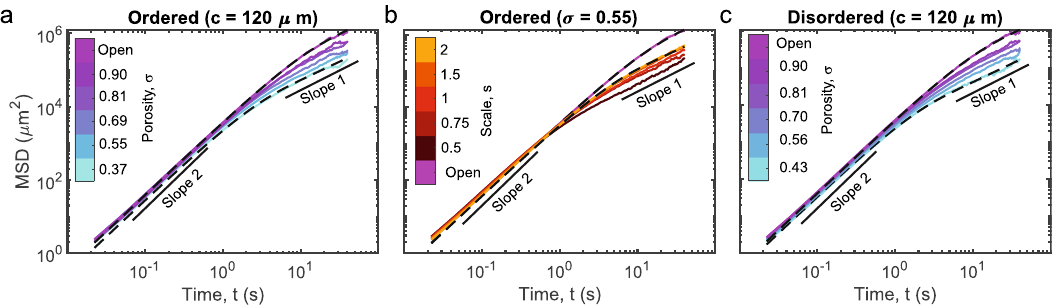
Fig. 3 Porous media universally hinders cell transport. Measured mean squared displacements (MSDs) for swimming bacteria (50 ≤ V s ≤ 80 μ m/s) in a ordered lattice with varying porosity, b ordered lattice with varying scale, and c disordered lattice with varying porosity. In a – c , the dashed black lines show two example fi ts each to an analytical persistent random walk model (see “ Methods ” ). Solid line segments indicate ~ t 2 and ~ t for the ballistic and diffusive regimes, respectively.